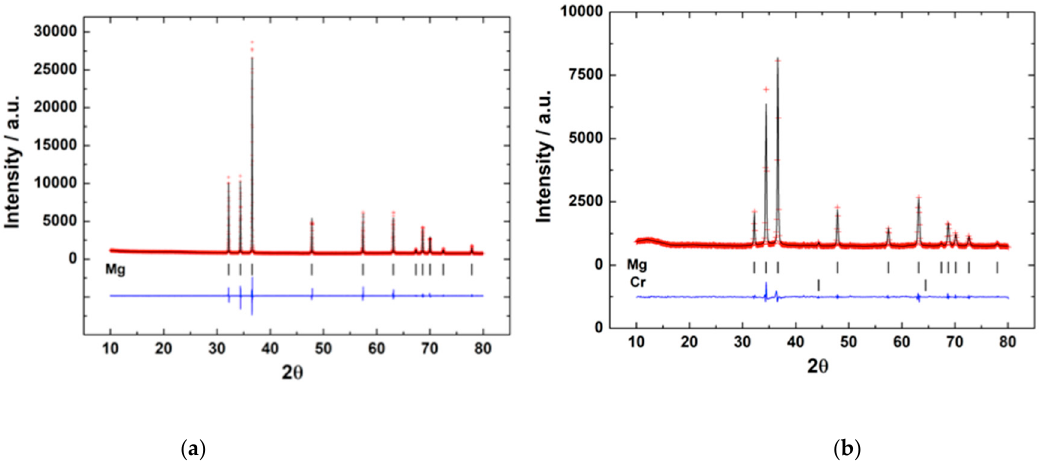
Figure 4. ( a ). Le Bail fits of the diffractogram of pure magnesium after thermal treatment. ( b ). Le Bail fits of the diffractogram of Mg-1Cr after thermal treatment.